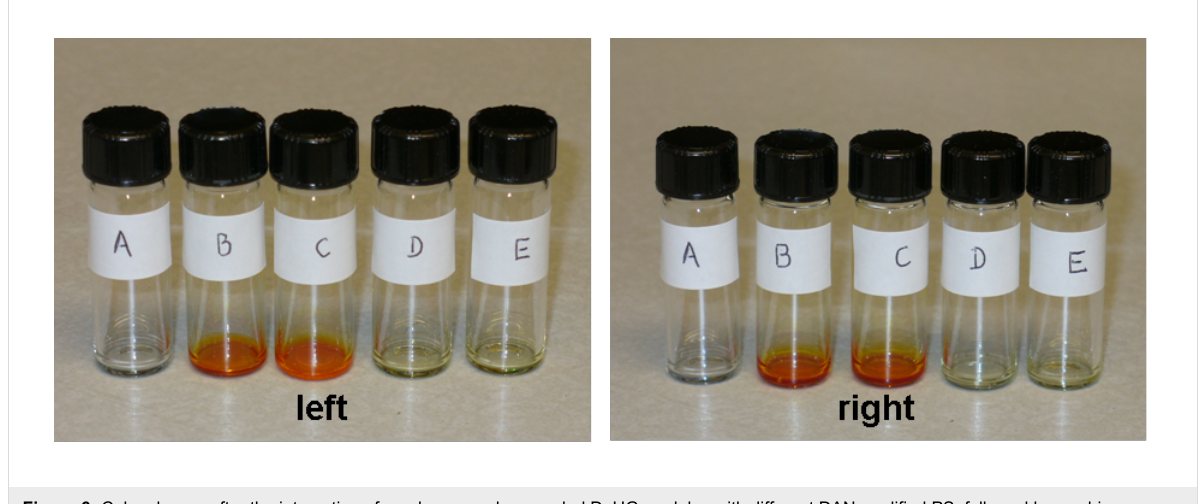
Figure 6: Color change after the interaction of azo-benzene dye-coupled DeUG modules with different DAN modified PS, followed by washing. Left: (A) PS with compound 12 , (B) PS-DAN (2.0 mol %) with compound 12 , (C) PS-DAN (2.0 mol %) with compound 18 , (D) PS-DAN (2.0 mol %) with compound 2 , (E) PS-DAN (2.0 mol %) with compound 15 . Right: (A) PS with compound 18 , (B) PS-DAN (5.0 mol %) with compound 12 , (C) PS-DAN (5.0 mol %) with compound 18 , (D) PS-DAN (5.0 mol %) with compound 2 , (E) PS-DAN (5.0 mol %) with compound 15 .